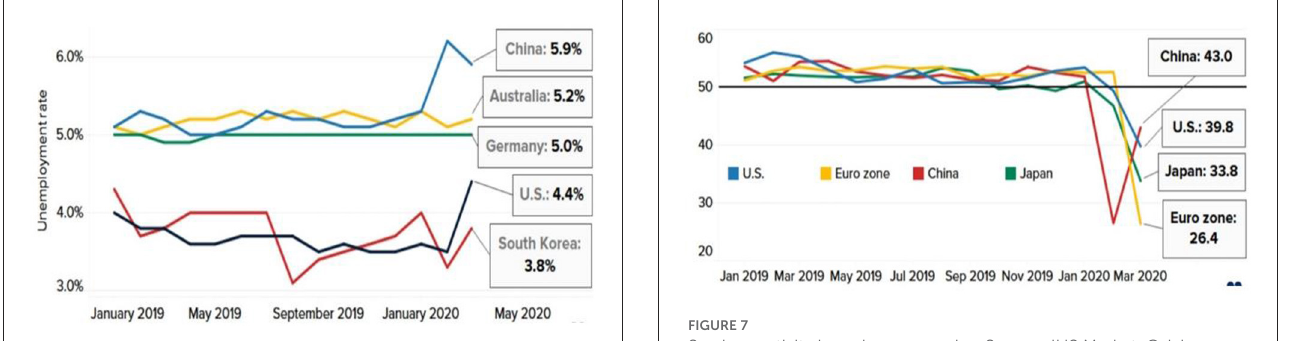
8.2%, respectively. The recovery is expected to be slow in the U.K. and Italy, two big, services-reliant economies that have been hit hard by the outbreak (Figure